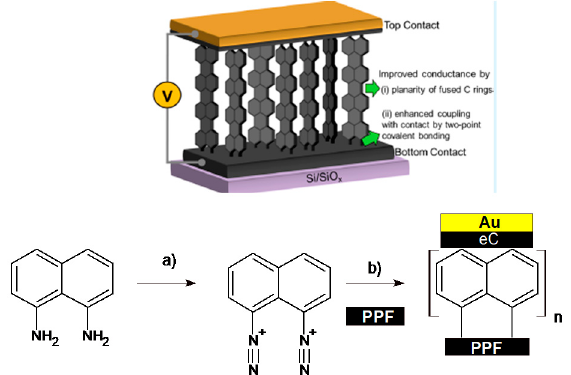
Figure 6. Molecular junction with carbon nanoribbons: ( a ) t -butylnitrite in ACN; ( b ) electrochemical reduction. PPF: pyrolyzed photoresist film, a very flat carbon surface, eC: electron-beam deposited carbon. From Reference [40] with permission of ACS.